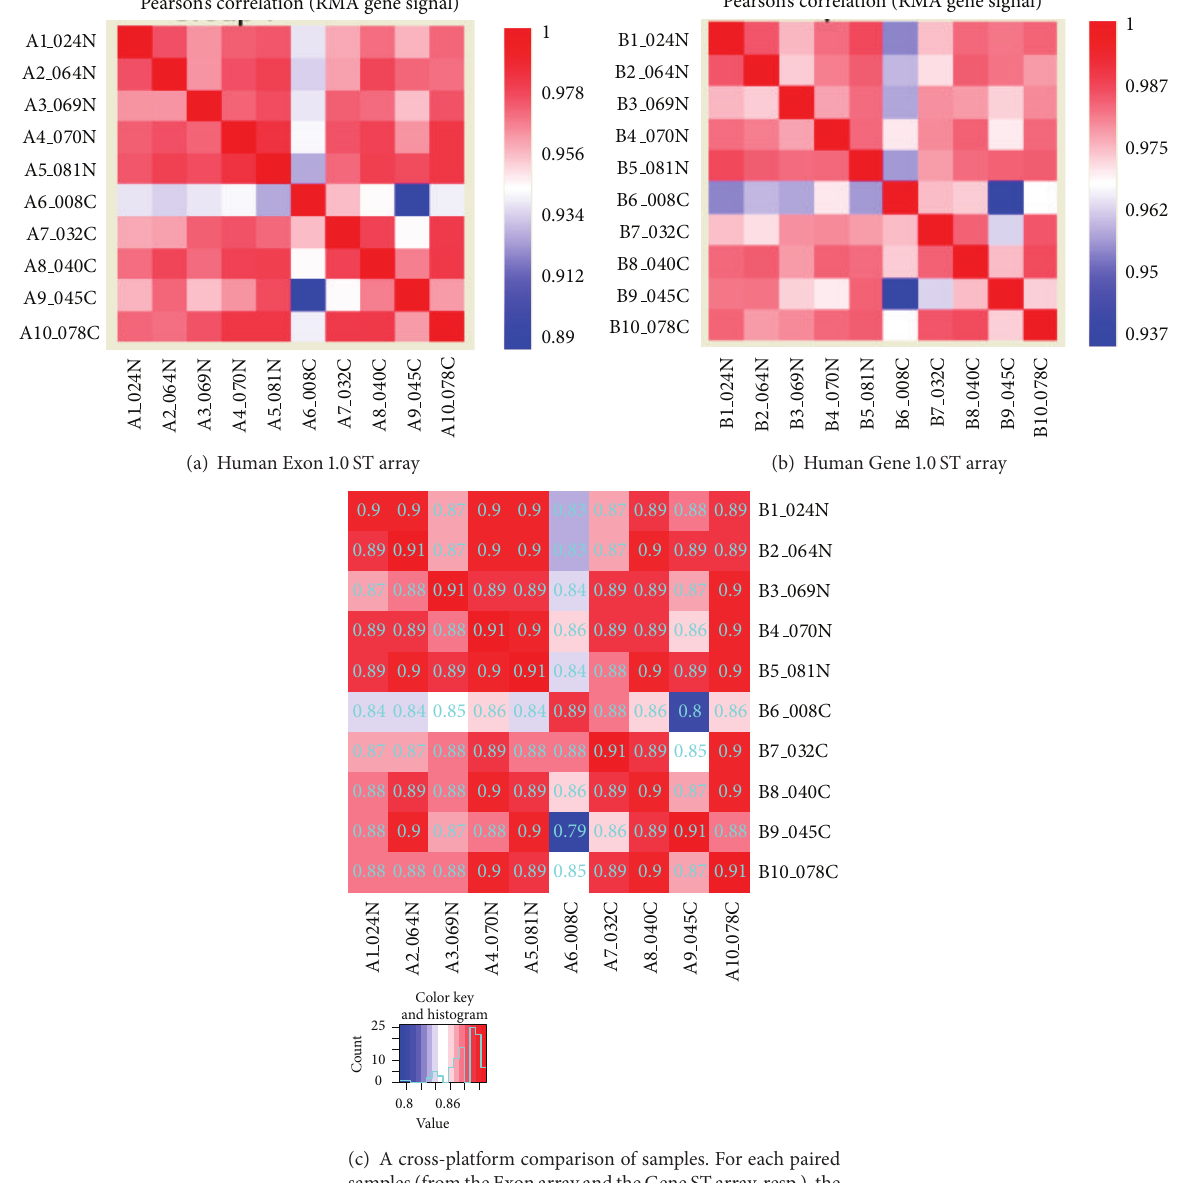
arrays. The distribution of the raw signal for each sample is shown in Figure 1(a) (the Exon array) and Figure 1(b) (the Gene array), respectively. Although there is a